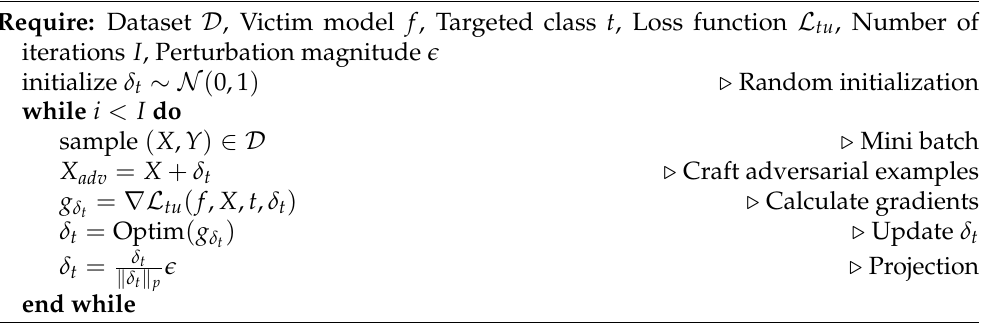
Algorithm 1 Targeted universal